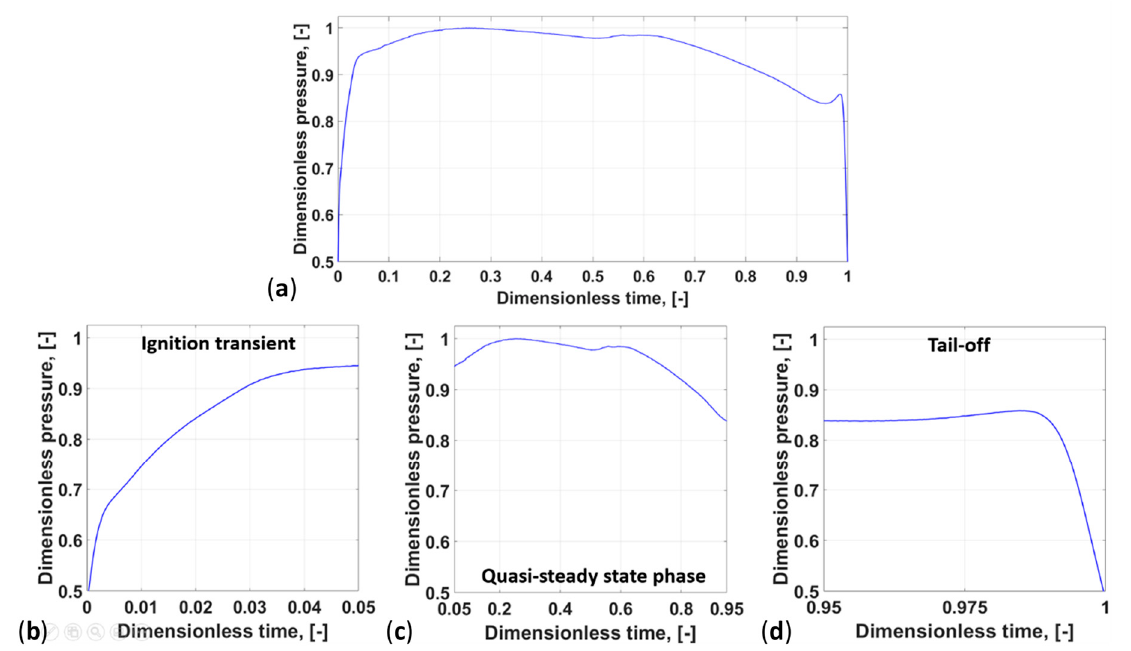
Figure 1. Combustion chamber pressure profile along time, taken from motor firings experimental data: ( a ) entire combustion period; ( b ) ignition transient phase; ( c ) quasi-steady state phase; ( d ): tail-off phase.